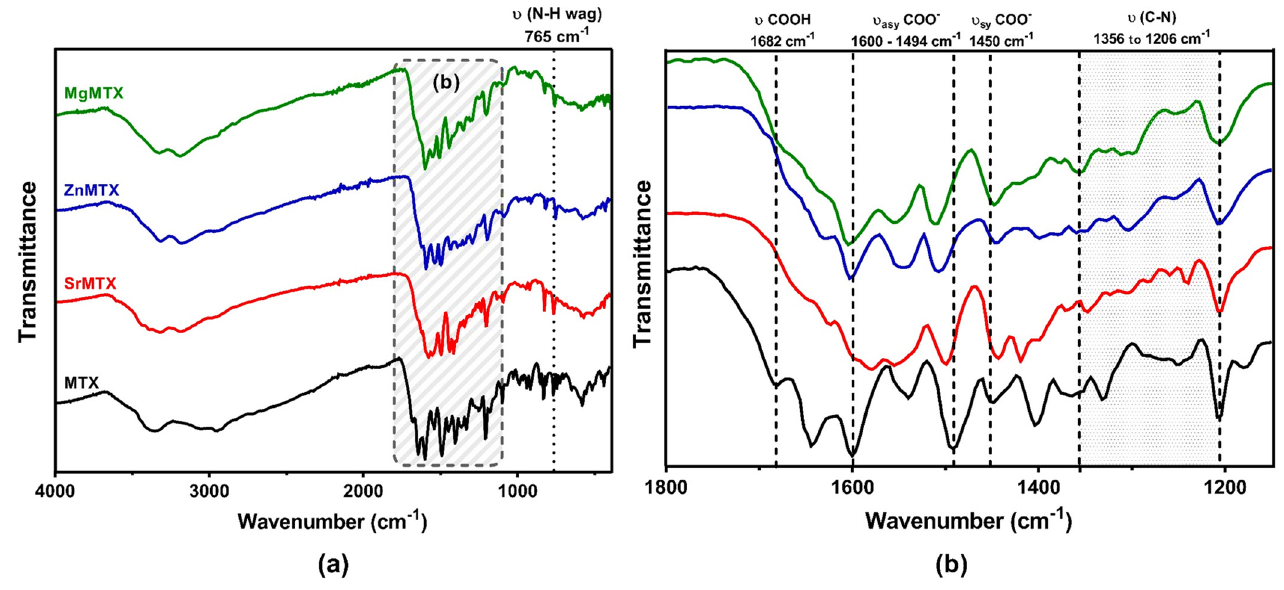
Figure 4. ATR–FTIR spectra of MTX and its derivatives ( a ) and zoomed-in region for their fingerprint determination ( b ). The most relevant vibrational frequencies of MTX are highlighted.